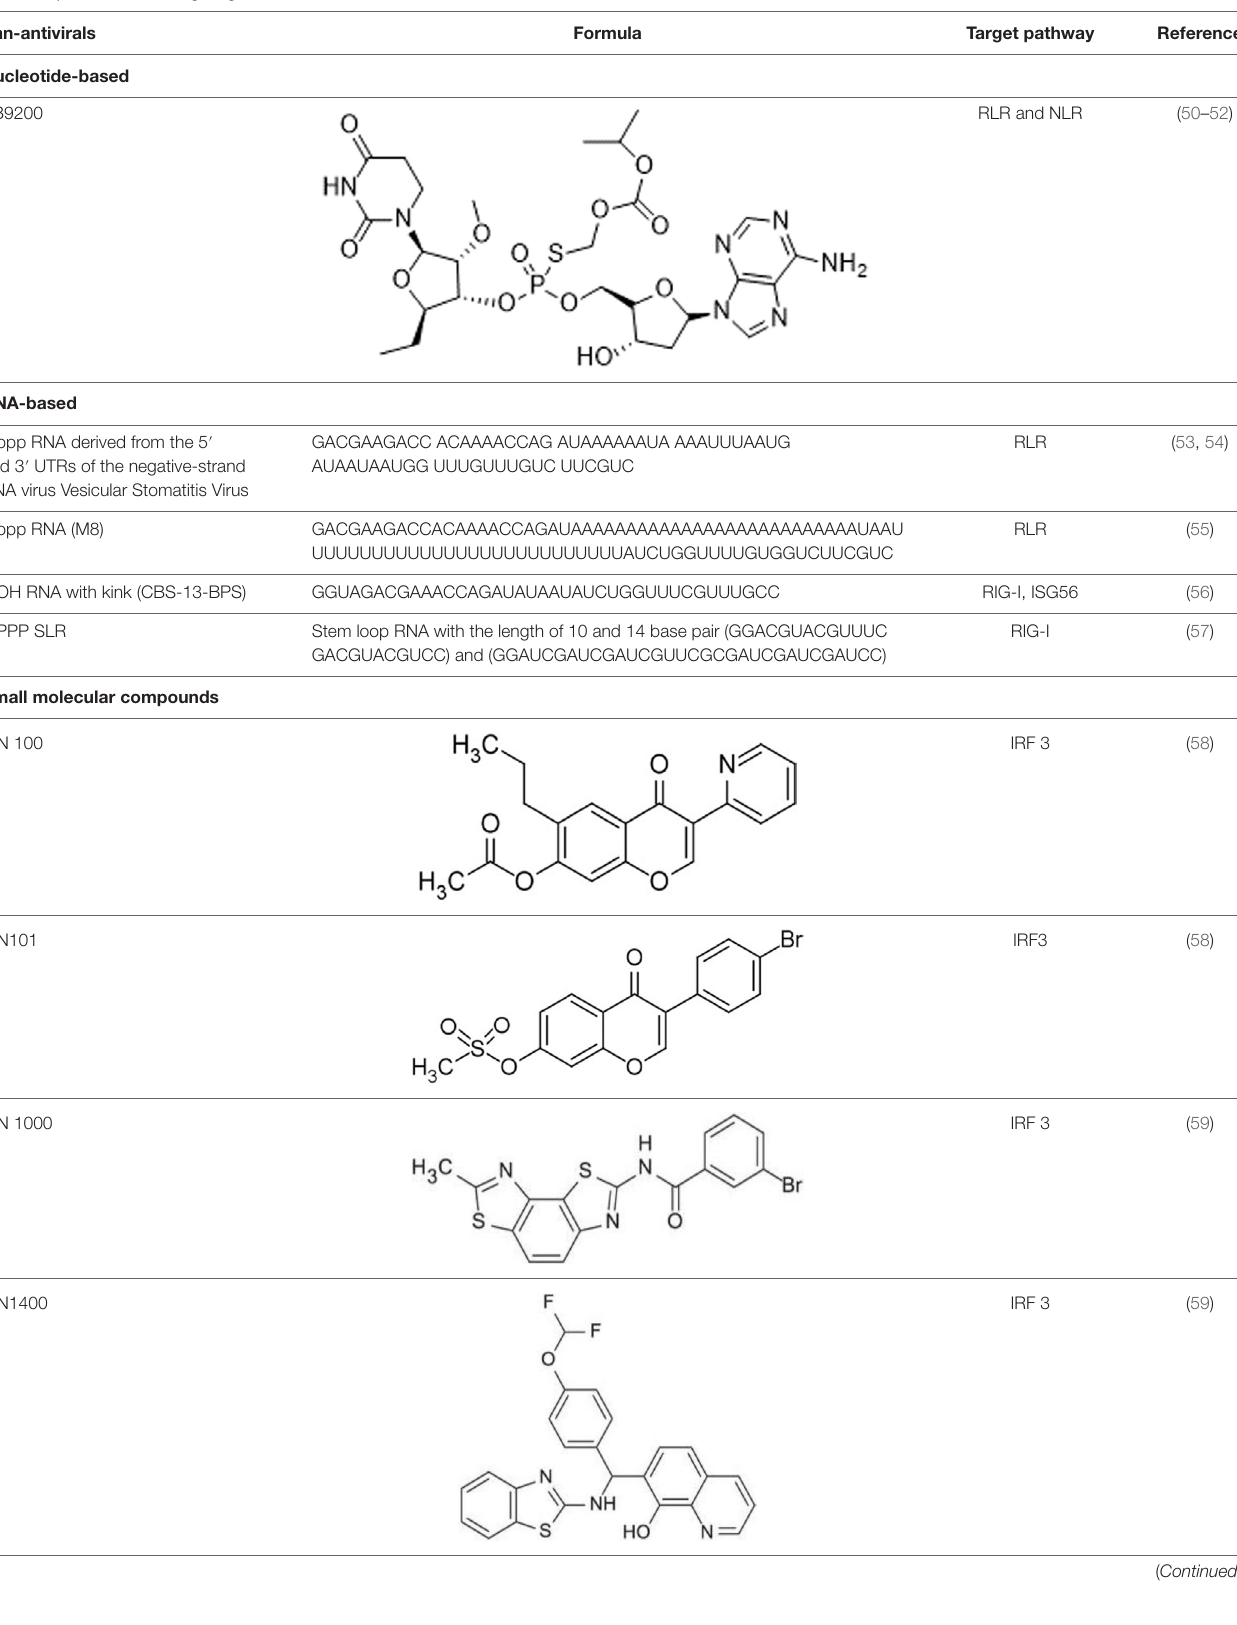
TABLe 1 | Pan-antivirals targeting